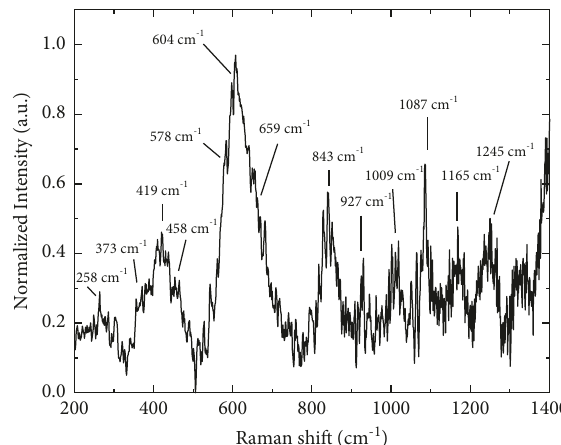
Figure 1: Experimental Raman spectrum ordinary Portland ce- ment. The positions of the vibrational bands are indicated.